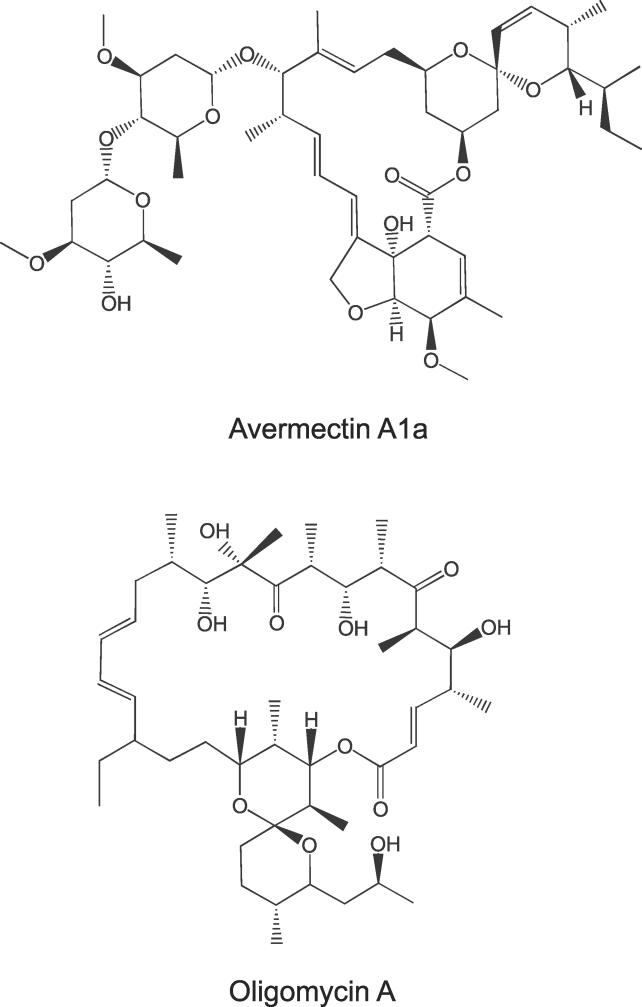
Representative Structures of Secondary Metabolites Classes Produced by the Large PKSs of S. avermitilis
The avermectin and oligomycin structures are examples of the respective compound groups. The exact structure of the polyene macrolide compound is not known.